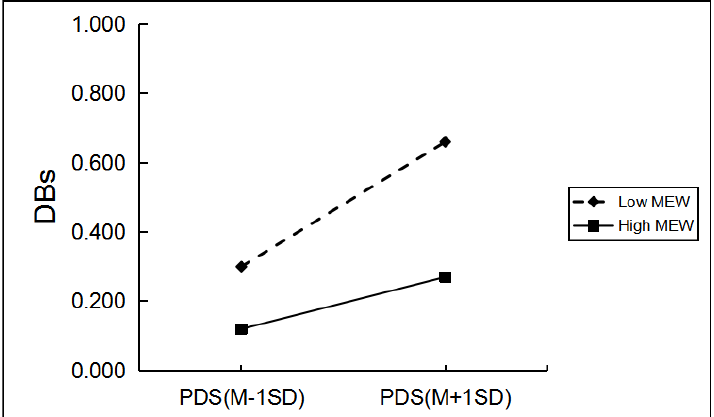
Figure 5. The two-way interaction between PT and MOP in predicting girls’ DBs. Note: PDS, the total score of pubertal development scale; MOP, mother over-protection; DBs, drinking behaviors.